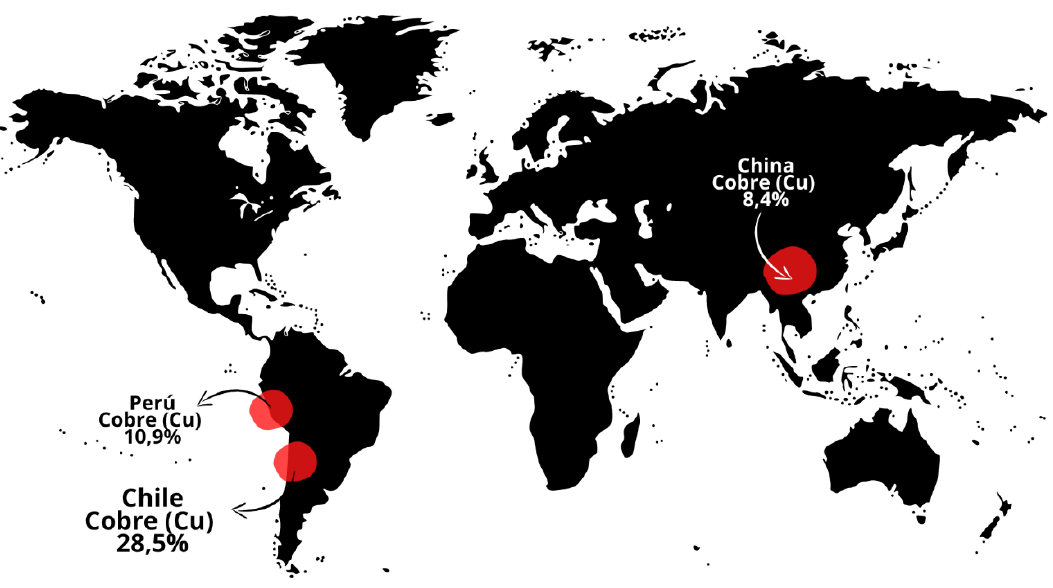
Figure 1. World copper production (SERNAGEOMIN 2021).